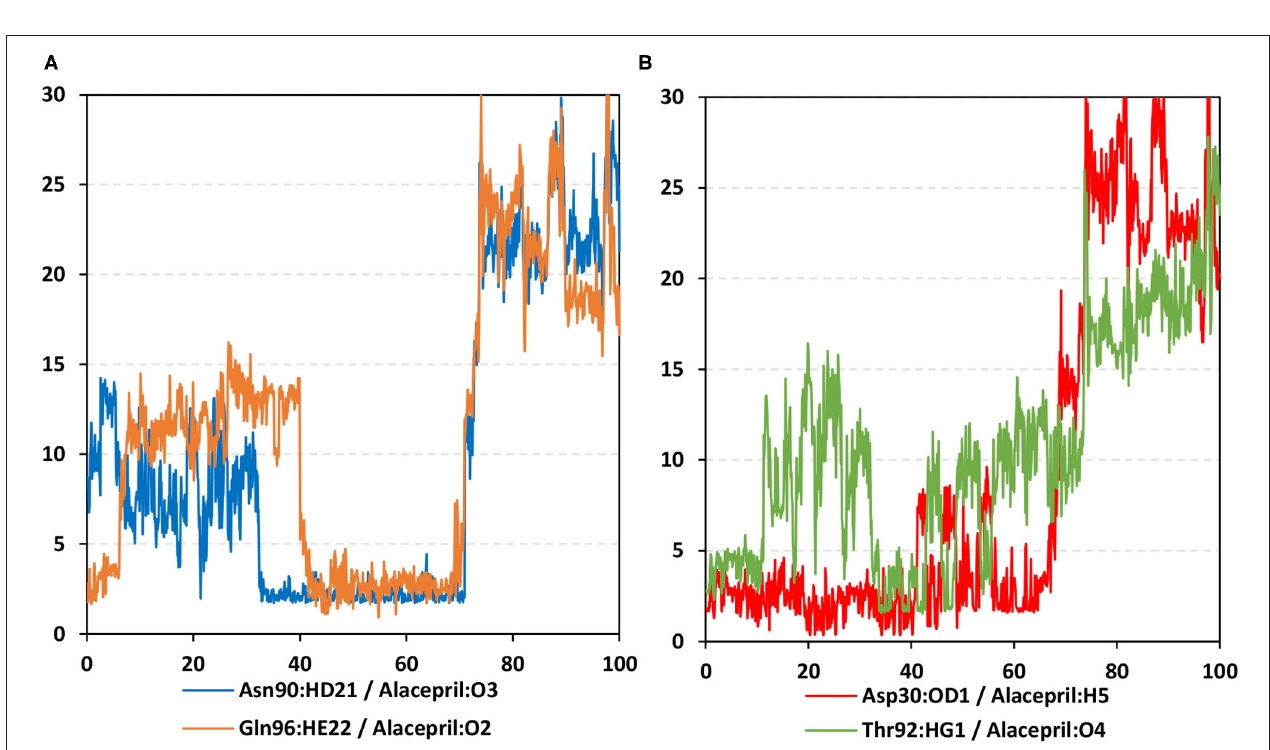
FIGURE 9 | Time-evolution of hydrogen bond distances for alacepril with h ACE2 key binding residues vs. 100-ns MD simulation time. (A) Asn90 and Gln96; (B) Asp30 and Thr92. The Y- and X-axes correlate to the apparent hydrogen bond (Donor-H…. Acceptor) distance in Å and MD simulation time in nanoseconds, respectively.